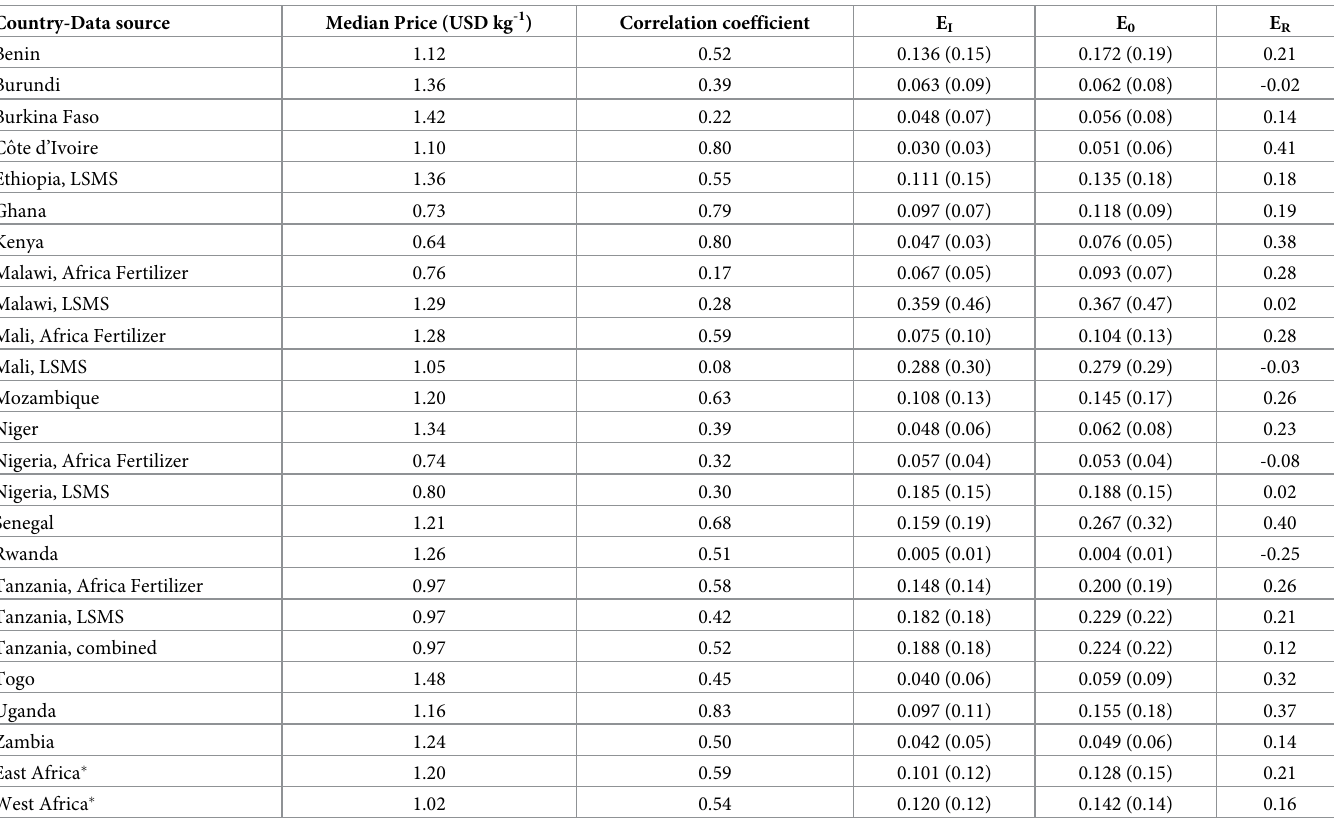
Table 3. Summary results for country level and regional models to predict the spatial price index (price divided by the national average) for urea and cross-valida- tion results: Pearson’s correlation coefficient between observed and predicted data price. E I : Root mean square error (USD kg -1 ). E 0 : Mean square error of the Null model. E R : Relative mean square error, calculated as: 1-(E I / E 0 ). E I and E 0 are expressed for the relative index and for the relative index multiplied by the national average price (USD kg -1 , values between parenthesis). For country-level models the data source was Africa Fertilizer, except where indicated